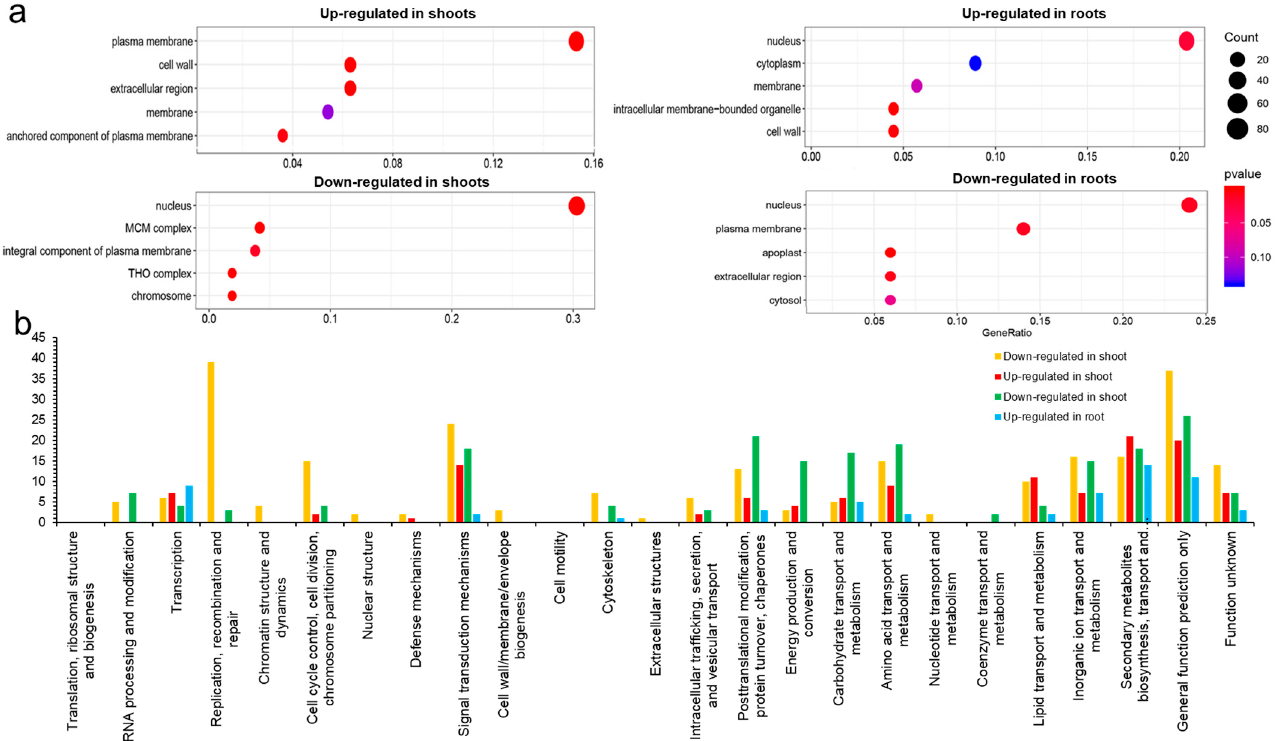
Figure 3. GO and KOG enrichment analysis of the up- and down-regulated differentially expressed genes (DEGs) in the roots and shoots: ( a ) cellular component enrichment of the up-regulated and down-regulated DEGs in the roots and shoots; ( b ) KOG enrichment analysis of the up- and down-regulated DEGs in the roots and shoots.